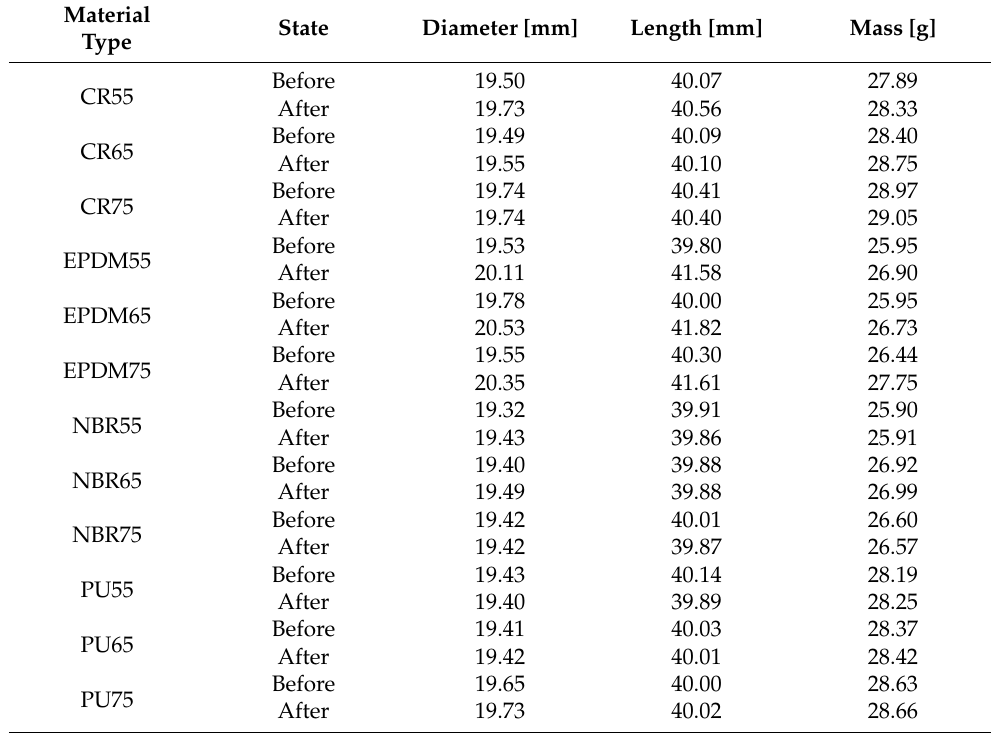
Figure 7. An example of vibroisolators during ageing in fuel and oil mixture. Table 1. Basic parameters of the tested absorbers before and after soaking in a mixture of fuel and oil for 48 h.